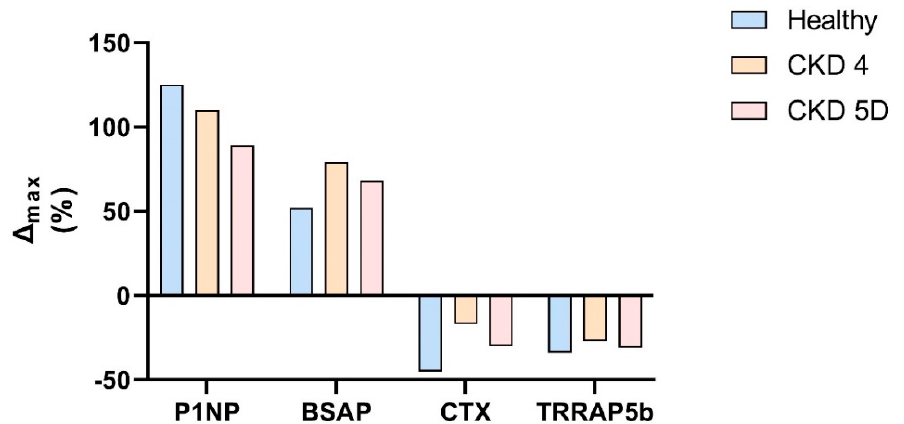
Figure 2. Peak percentual change in bone turnover markers from baseline after a single injection of romosozumab 210 mg, according to renal function. Adapted from [88]. Healthy—healthy controls; CKD 4—chronic kidney disease stage 4; CKD 5D—chronic kidney disease stage 5D (dialysis);